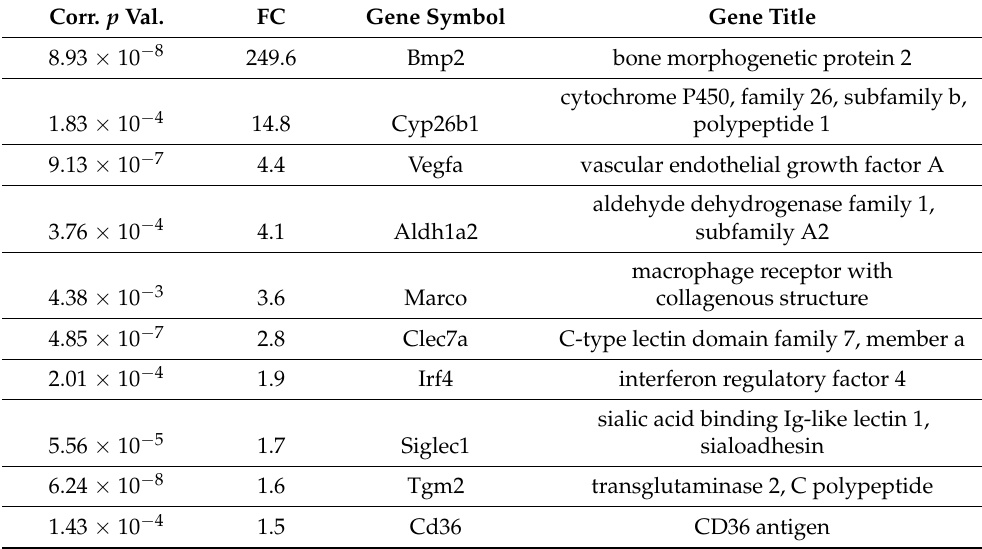
Table 3. List of the upregulated M2 macrophage-associated genes differentially expressed between 48 h DMSO- and 48 h DHR-treated BMDMs (based on at least 1.5-fold change and corrected p value < 0.05). M2 macrophage-associated list containing 73 genes was generated based on the https://www.bosterbio.com/tissue-markers-cell-markers/macrophage-markers (accessed on 9 Au- gust 2022) website and extended with genes from literature search and cross-referenced with the 357 genes, which were upregulated following 48 h DHR-treatment. Corr. p Val. FC Gene